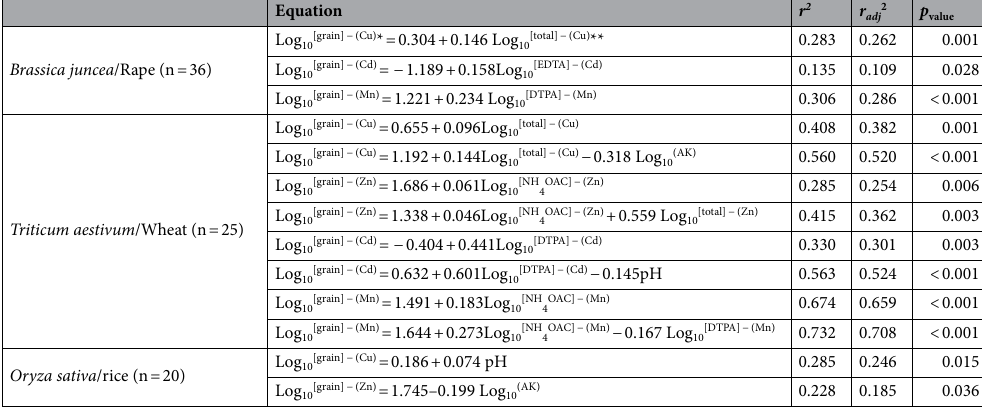
Table 5. Summary of stepwise multiple regression equations for metal concentrations in the grains of three crop species as function of soil total or extractable metal concentrations and soil properties. *: [grain] − (Cu) means Cu concentrations in grains; **: [total] − (Cu) means total Cu concentrations in